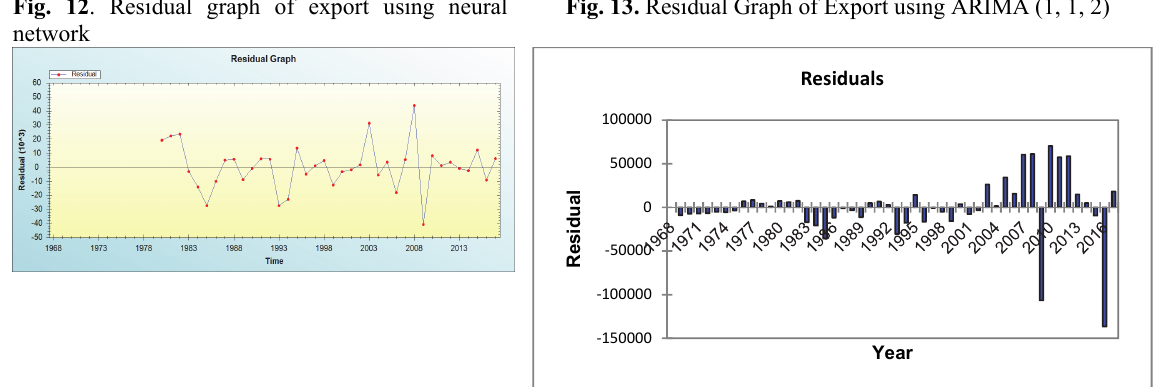
Fig. 13. Residual Graph of Export using ARIMA (1, 1, 2)